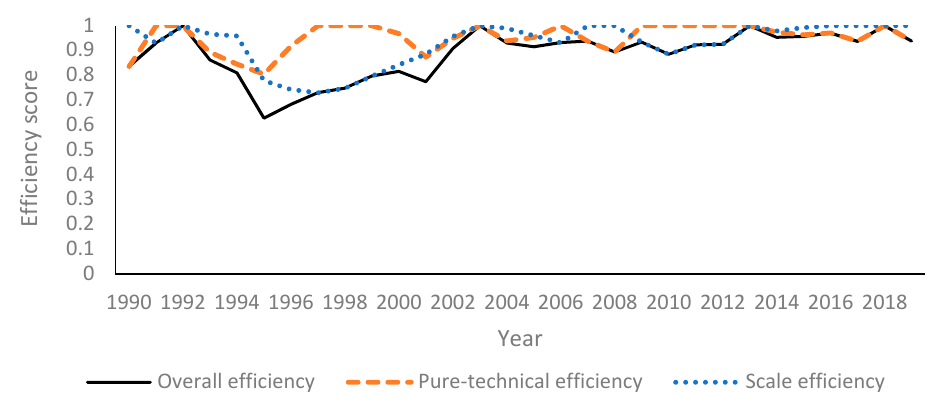
Figure 2. Technical efficiency of timber production by Polish State Forests in the years 1990–2019 according to the one output multiple inputs model. Table 3. Technical efficiency of timber production by Polish State Forests in 1990–2019 according to the one output one input